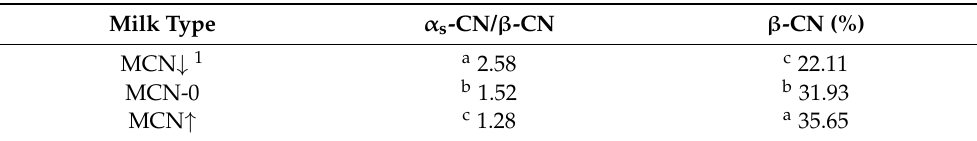
Table 3. The ratio of α s -casein ( α s -CN) to β -casein ( β -CN) and percentage of β -casein in all casein fractions of milks to produce different variants of Gouda